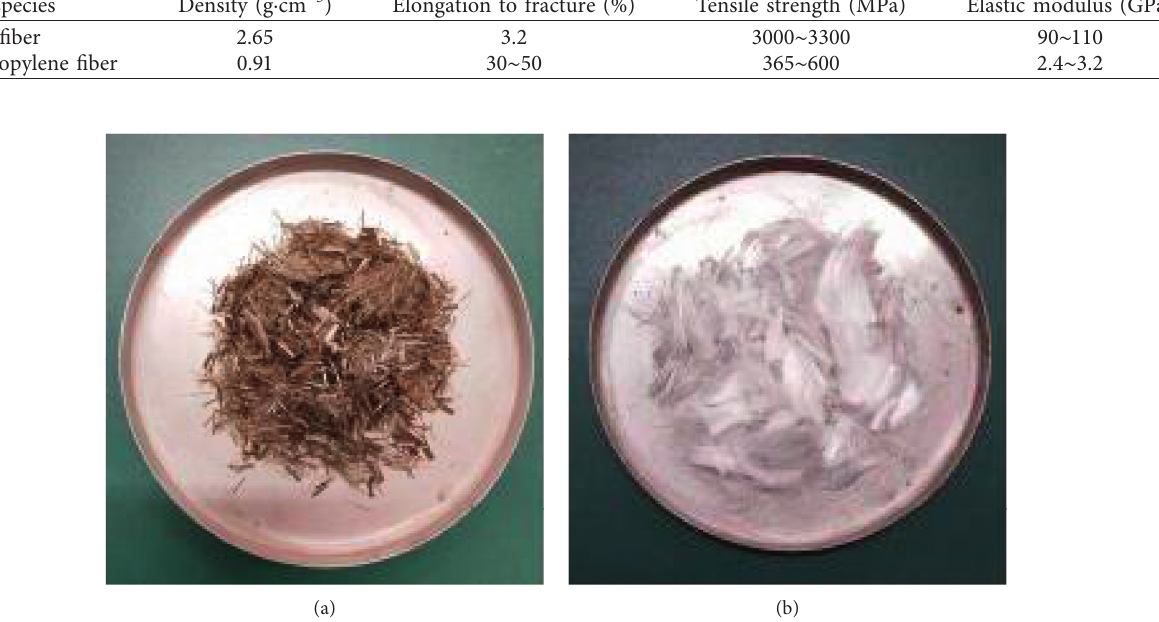
Figure 1: Fiber types: (a) basalt fiber; (b) polypropylene fiber.